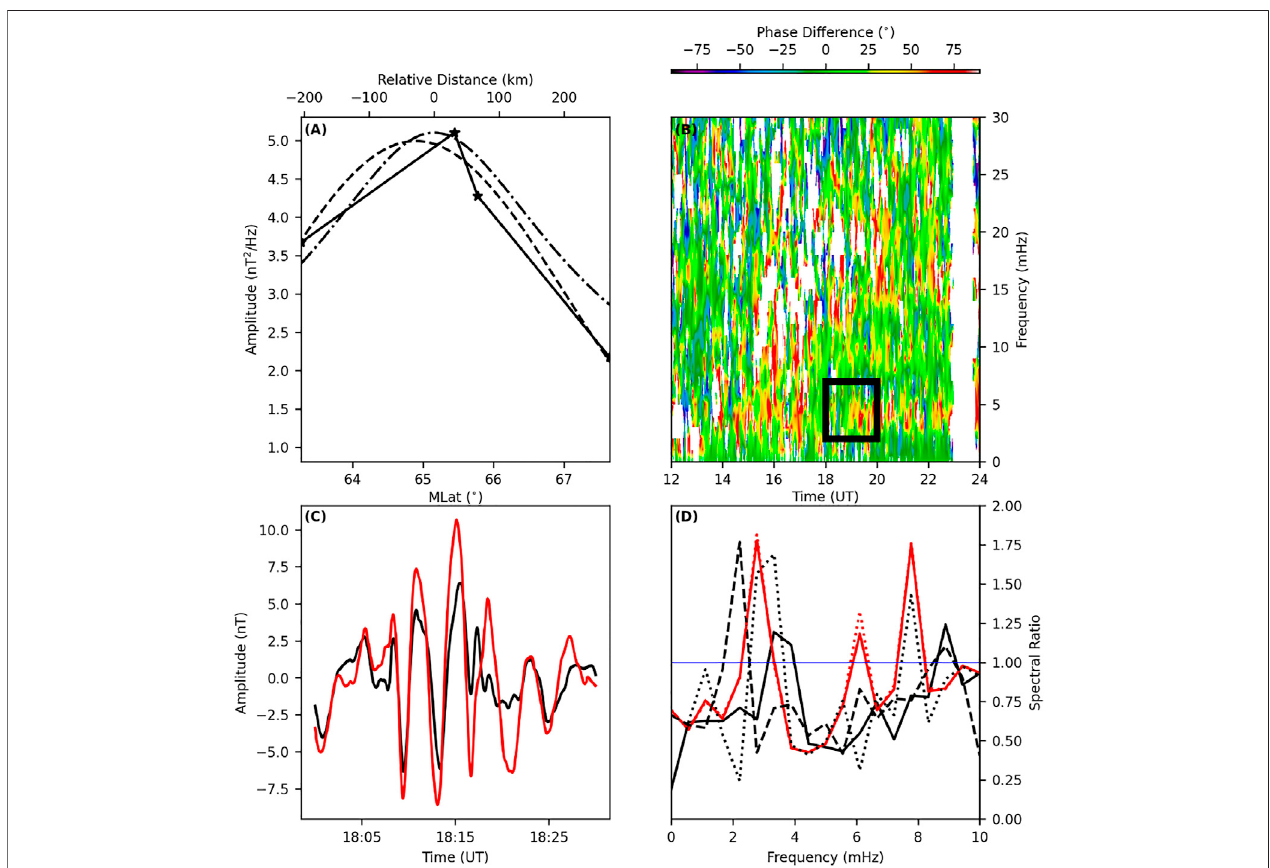
FIGURE 4 | (A) Latitudinal spectral amplitude curve fi ts; Linear piece-wise (solid, stars at station locations), Gaussian (dashed) and FLR amplitude ( Eq. 3 , dash- dotted) versus MLat/km, (B) Dynamic cross phase between BEL-ZAG, (C) Time series of the BEL (black) and ZAG (red) magnetometer stations, and (D) Spectral amplitude ratio for the boxcar (black, dotted), Hann (red, dashed), Hamming (red, solid), exponential taper (black, solid), and multi-taper (black, dashed) FFT window processing for the BEL-ZAG magnetometer data for the 19 June 2015